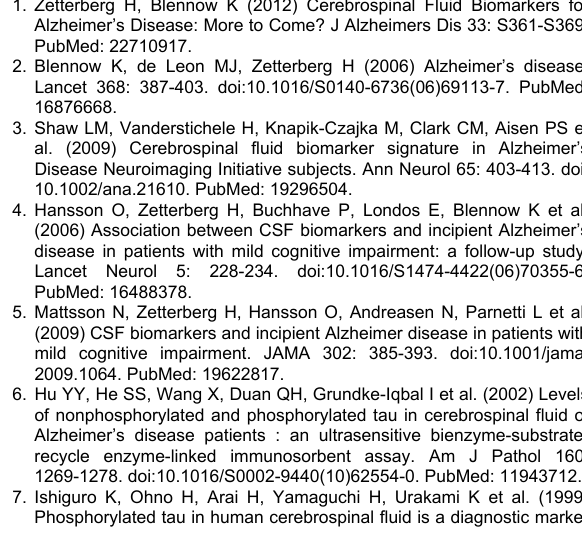
Figure S7. Analysis of tau and ptau levels in 20 AD and 20 control CSF samples. A set of 20 AD and 20 age-matched normal control CSF samples were analyzed using INNO-BIA AlzBio3. Statistics based on 2-tailed Student’s t test comparison of log-transformed data (tau and ptau) or untransformed data (Aβ42). * p < 0.05; ** p< 0.01; *** p < 0.001.